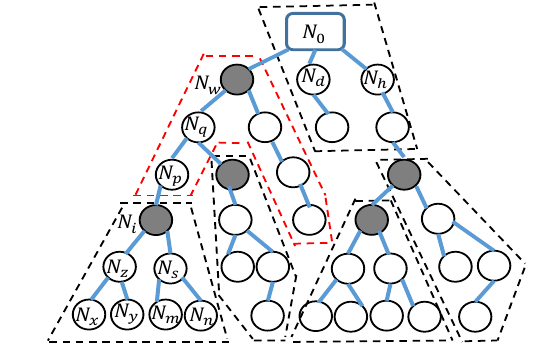
Figure 2. An example of dynamic grouping: the dotted areas are groups and the dark nodes are the